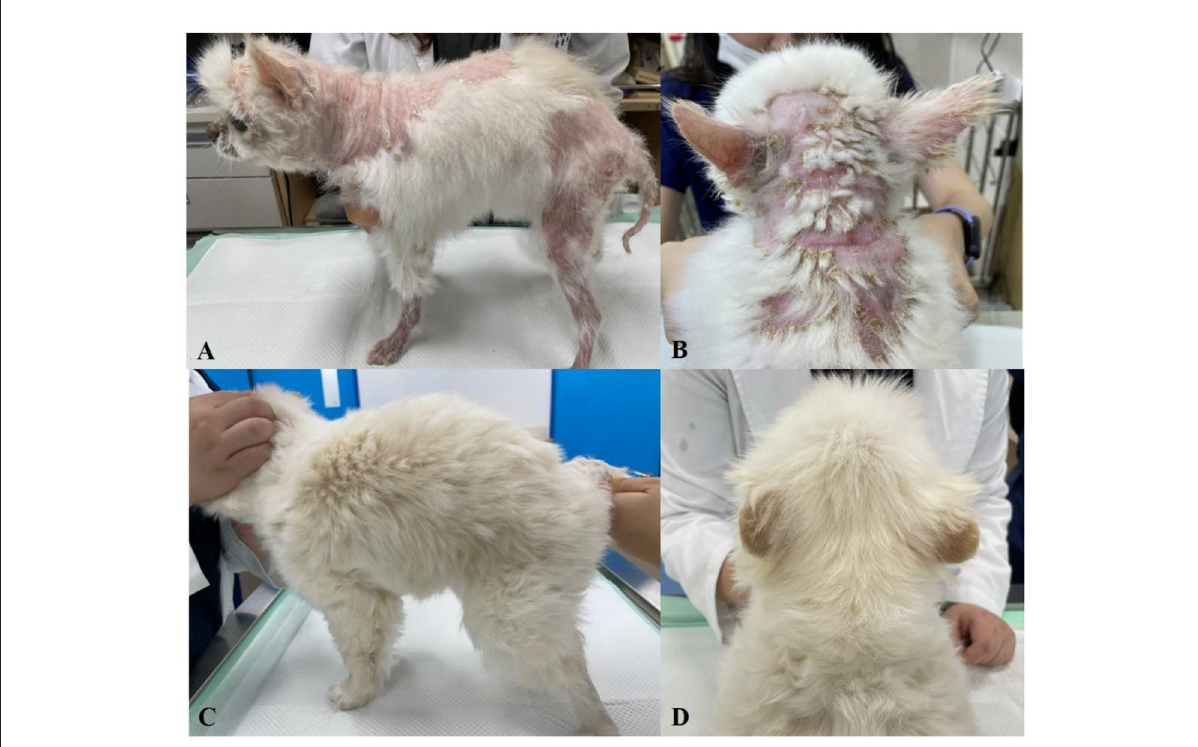
FIGURE3 Photographs of the skin condition of Case 3. (A,B) Systemic alopecia and crusts at presentation. (C,D) 10 months later, after treatment, alopecia was significantly improved and the crusts